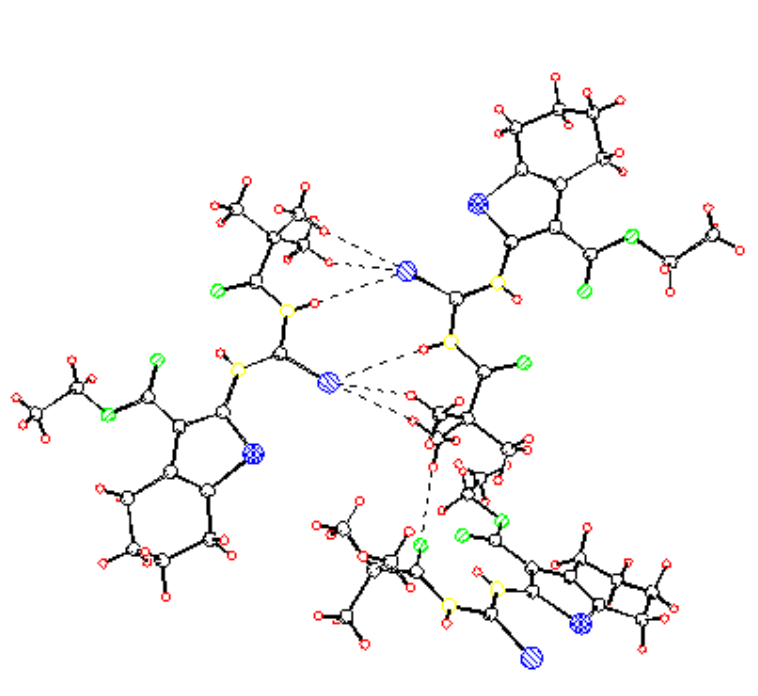
Figure 3. Intermolecular interactions between two molecules of 2 according to the X-ray